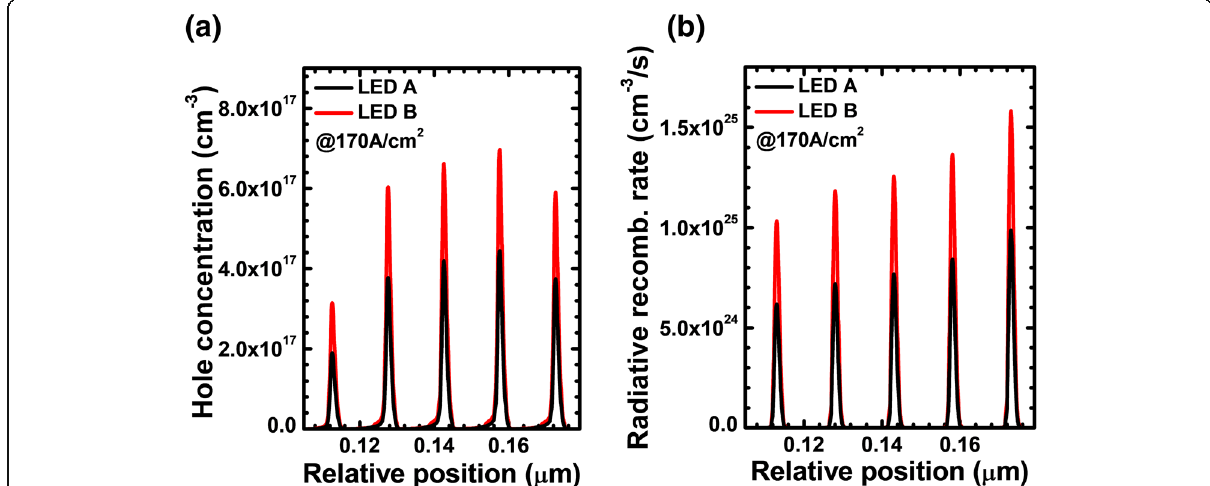
Fig. 4 a Hole concentration profiles and b radiative recombination rate in the MQW region for LEDs A and B at the current density of 170 A/cm 2 ,